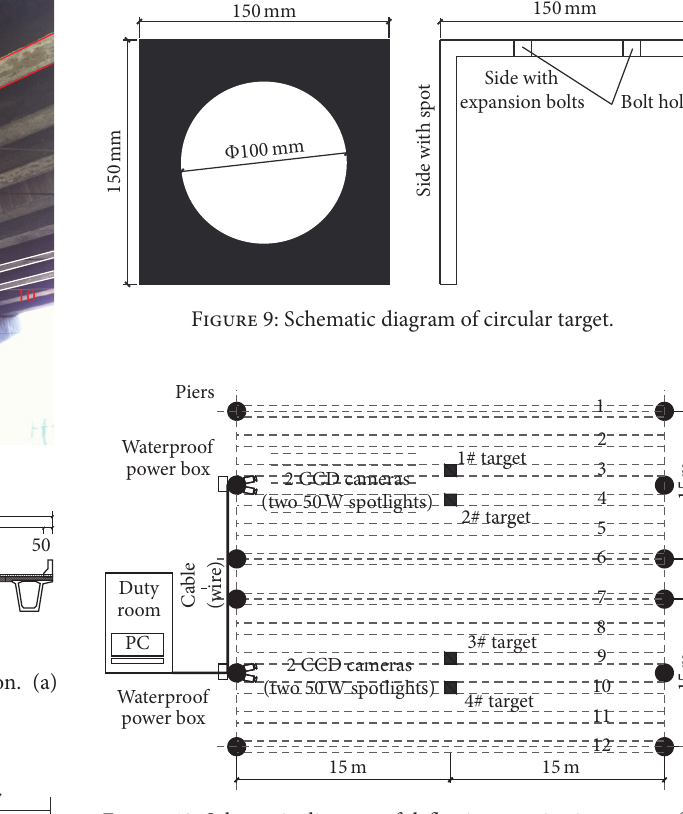
Figure 10: Schematic diagram of deflection monitoring system for Songjiazhuang cloverleaf